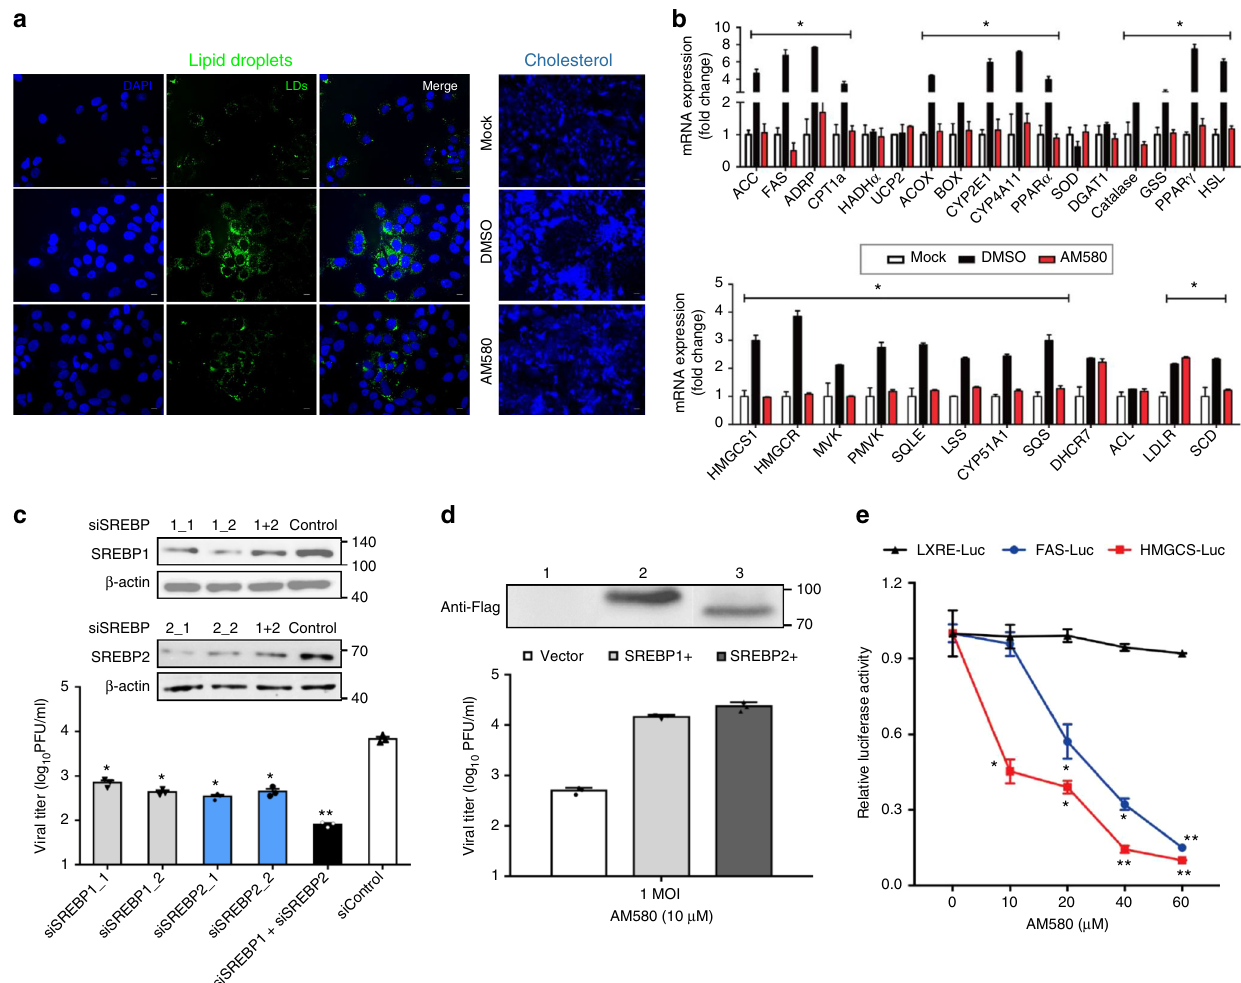
Fig. 4 SREBPs were essential for MERS-CoV replication. a AM580 decreased cellular lipid droplets (LDs) and cholesterol levels. Huh7 cells were infected with MERS-CoV at 0.01 MOI for 24 h, in the presence of 0.1% DMSO or 20 µ M AM580 or mock-infected. Cells were fi xed and stained with DAPI (blue) and BODIPY 493/503 lipid probe (green) for LDs detection, or with fi lipin (blue) for intracellular cholesterol visualization. Scale bar: 20 µ m. b The expression of multiple genes in fatty acid (upper) and cholesterol (lower) synthesis pathways were analyzed by RT-qPCR, respectively. * indicates p < 0.05 comparing DMSO and AM580 by one-way ANOVA. c siRNA knockdown of either SREBP1 (two distinct siRNA 1_1 and 1_2) or 2 (siRNA 2_1 and 2_2) or both SREBP1 and 2 (siRNA 1_2 and 2_2) reduced MERS-CoV replication. The knockdown ef fi ciency and speci fi city was evaluated with western blot. siRNA- treated cells (100 nM siRNA for single knockdown and 50 nM each for double knockdown for 48 h) were infected with MERS-CoV (0.001 MOI and 24 hpi). Viral titer in the cell culture supernatant was evaluated with plaque assay. One-way ANOVA was used for comparison with the control siRNA